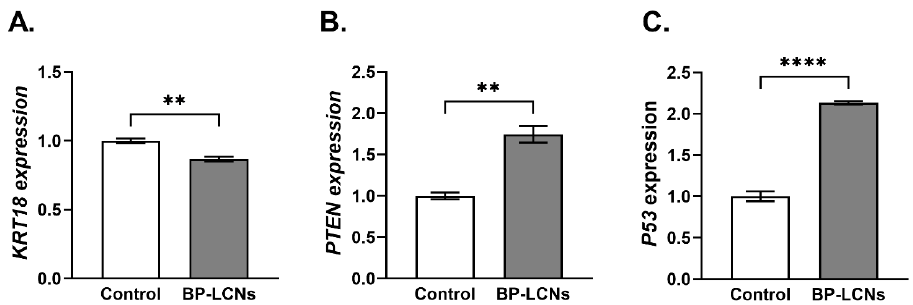
Figure 11. Effects of BP-LCNs on mRNA levels of KRT18 , PTEN, and P53 in A549 cells. A549 cells were incubated at 37 °C for 24 h in the absence or presence of BP-LCNs (final concentration 5 µM). The figure shows mRNA levels of KRT18 ( A ), PTEN ( B ), and P53 ( C ). The mRNA levels were measured by RT-qPCR and normalized against GAPDH . The values represent Mean ± SEM of 3 independent experiments. Note: ** p <0.01, **** p <0.0001. Abbreviations: KRT18 , gene encoding keratin 18; PTEN , gene encoding phosphatase and tensin homology; and P53 , gene encoding tumor protein P53). Abbreviation: BP-LCNs, berberine–phytantriol liquid crystalline